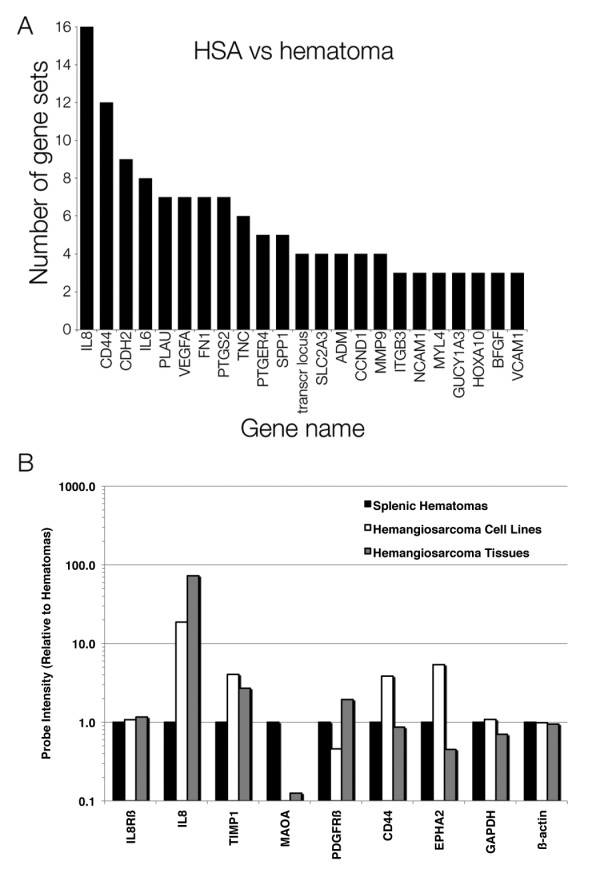
Gene set enrichment analysis validates the hypothesis that the hemangiosarcoma gene set is involved in hypoxia, inflammation, and cancer. (A) Bar graph representing the number of gene sets that were enriched in hemangiosarcoma samples versus splenic hematoma samples. Each of 23 genes on the x-axis was present in the number of gene sets indicated on the y-axis (of 30 where FDR < 0.05). (B) Bar graph representing the direction and magnitude of change in expression for six representative genes (IL8, TIMP1, MAO, PDGFRβ, CD44, EPHA2), one invariant control (IL8Rβ) and two housekeeping controls (GAPDH, β-actin) relative to the expression in splenic hematomas. Data for each group (three splenic hematomas, 14 hemangiosarcoma cell lines, and three hemangiosarcoma tissues) passed quality assurance using Affymetrix algorithms provided in GeneData Expressionist Refiner. Probe signal levels were quantile-normalized and summarized using the GeneChip-Robust Multichip Averaging (GC-RMA) algorithm. Normalized files were imported into GeneData Expressionist Analyst so average expression values for each group, based on multiple-probe hybridization data, could be used in the comparisons.